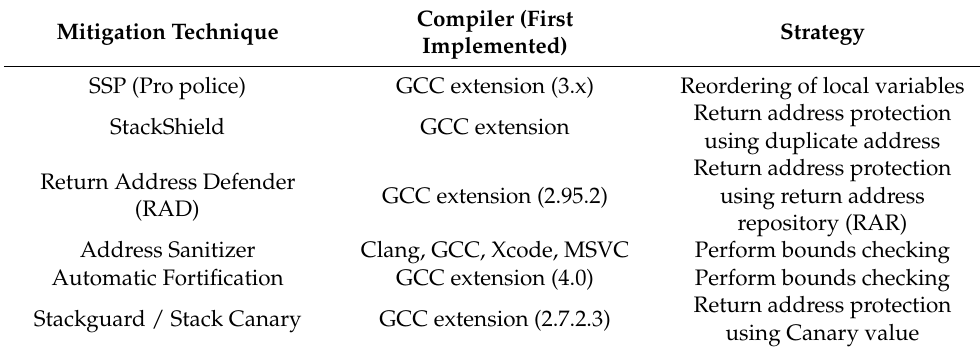
Table 6. Summary of Compiler